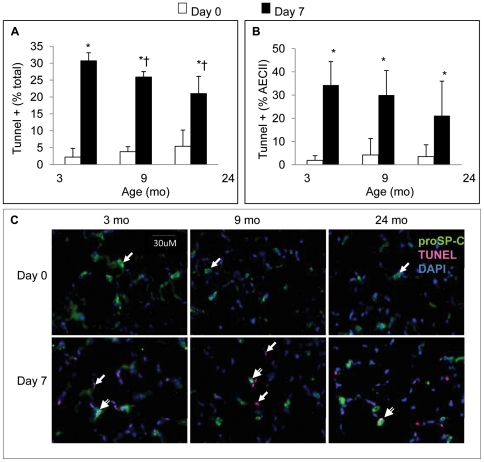
The effect of age on post-PNX cellular apoptosis.Apoptosis as a function of age (3, 9, and 24 mo) and PNX (day 0 vs. 7). A. Percentage of nucleated cells that were TUNEL positive; B. Percentage of proSP-C positive (AECII) cells that were TUNEL positive. For A. and B., * P<0.05 compared to day 0 within age group; † P<0.05 compared to d7 in 3 mo old mice; n = 5/group. Data are expressed as means ± SEM; C. Examples of TUNEL and proSP-C immunostaining used for enumeration of single (single line arrows) and double (double line arrows) staining (400×mag).